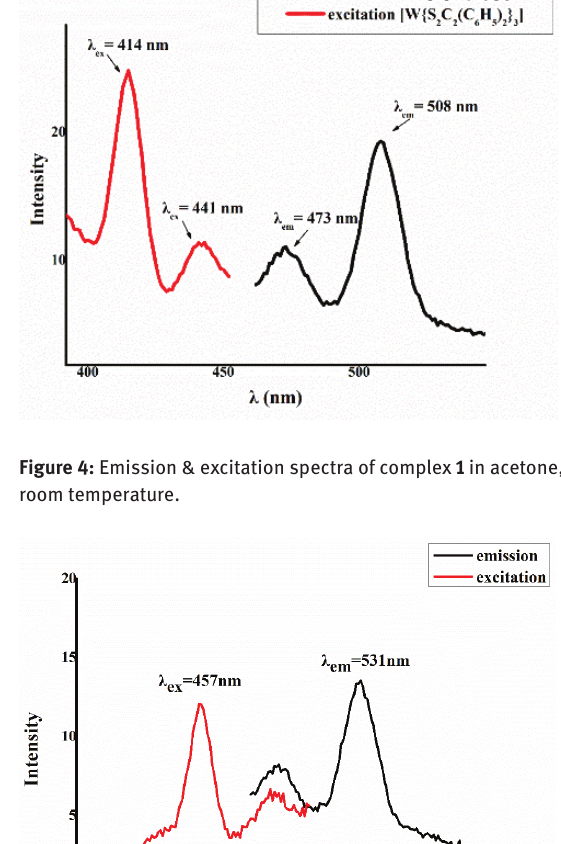
and ε of the complexes 1 (0.04mM) in acetone & 2 Table 1: . λ max (0.3mM) in various solvents .